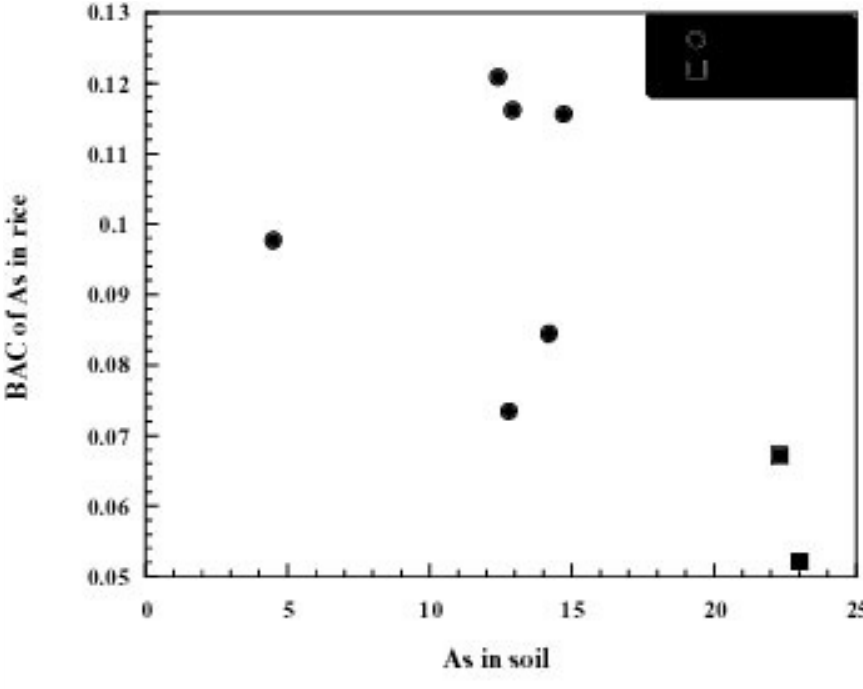
FIGURE 6 . Biological absorption coefficient (BAC = Cp/Cs) of rice and As concentration in soil from the study areas.